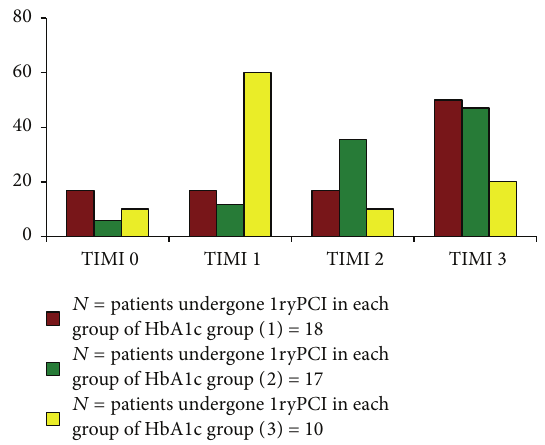
Figure 3: TIMI flow grade in primary PCI cases ( 𝑛 = 45 ).